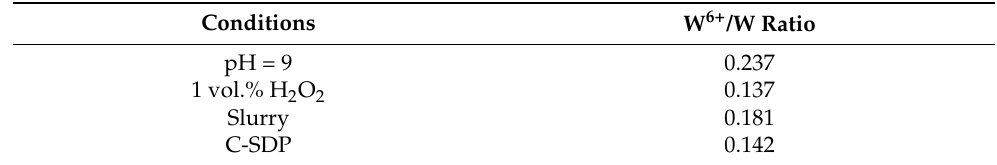
Table 3. Analysis results of XPS peak area of